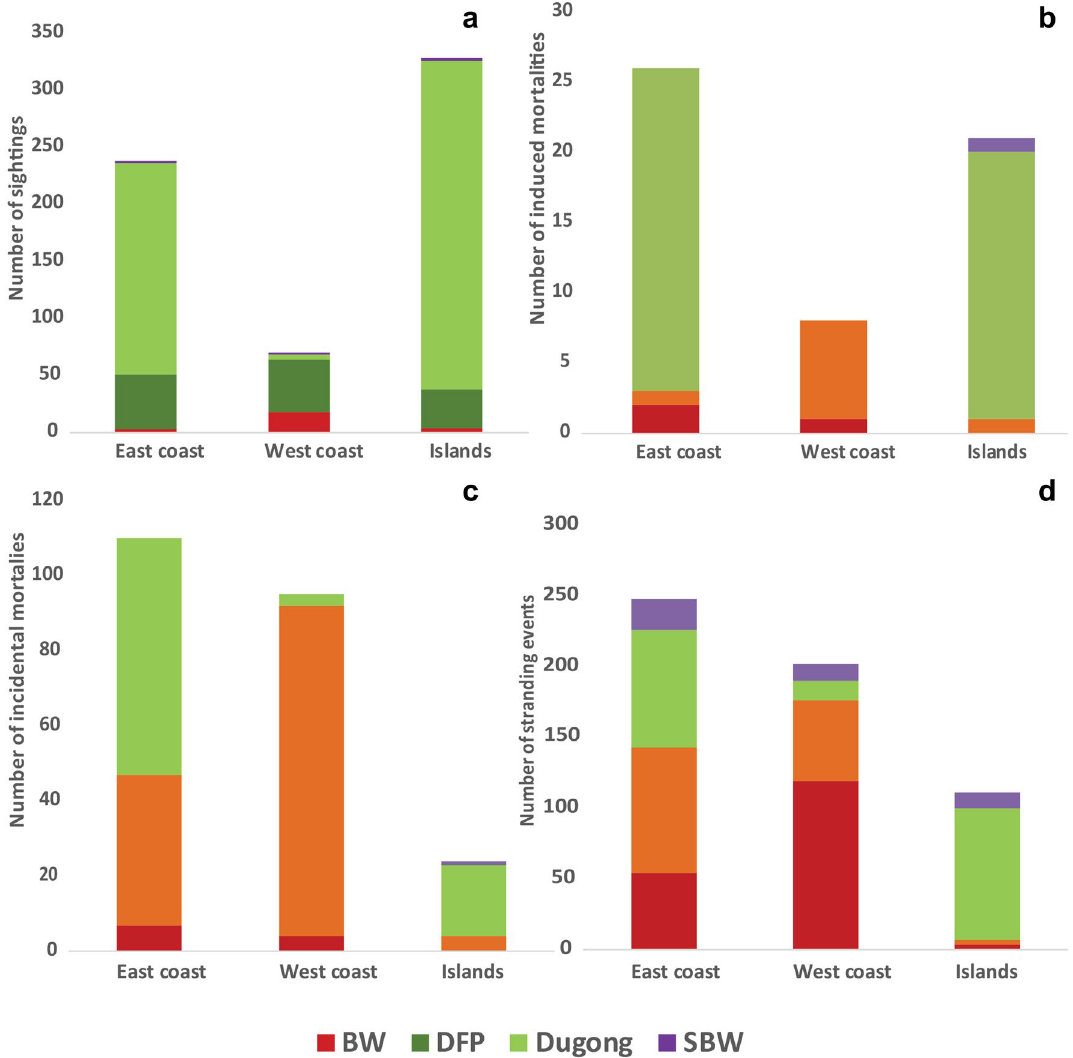
Figure 1. Marine mammal records obtained from data compiled between years 1748 – 2017 along the east coast, west coast and the islands of India for the groups i.e., baleen whales (BW), dolphins and finless porpoise (DFP), sperm and beaked whales (SBW) and dugongs, given as color-coded stacked bars where ( a ) sighting records—records where live animals were sighted ( b ) induced mortalities—records where animals were reported hunted or killed or were driven ashore, ( c ) incidental mortalities—records where animals were found dead after entanglement in fishing nets or being struck by vessels and ( d ) stranding records—records where dead or live animals were found washed ashore, or floating near shore or stranded alive and were attempted for